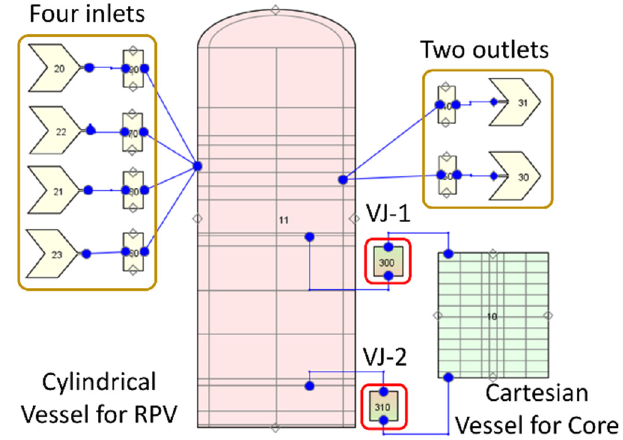
Figure 3. The AP1000 model demonstrates the multi-vessel coupling rules.